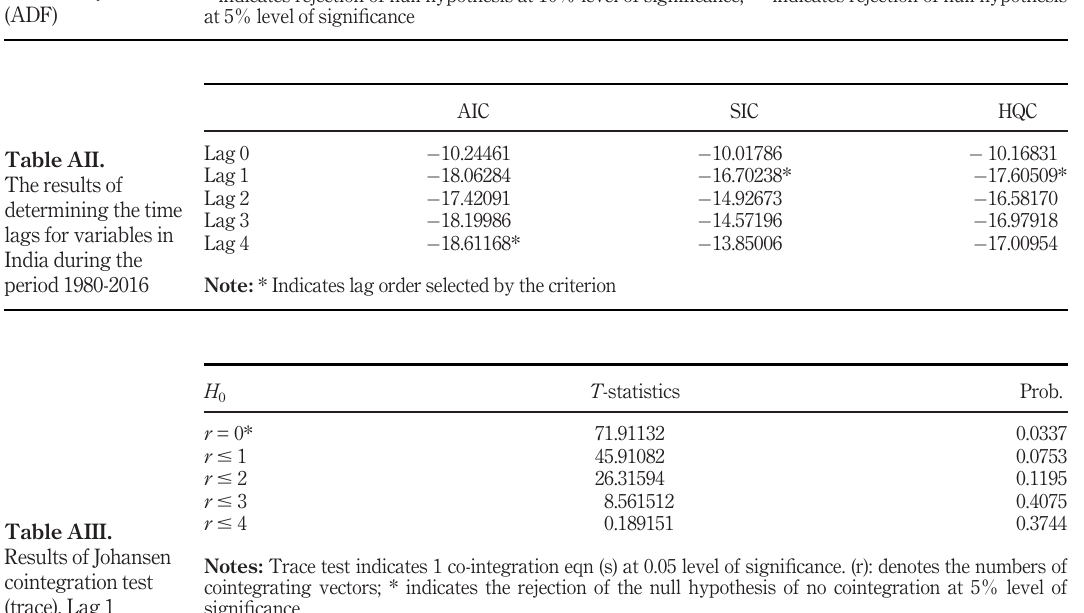
Table AI. Stationarity test